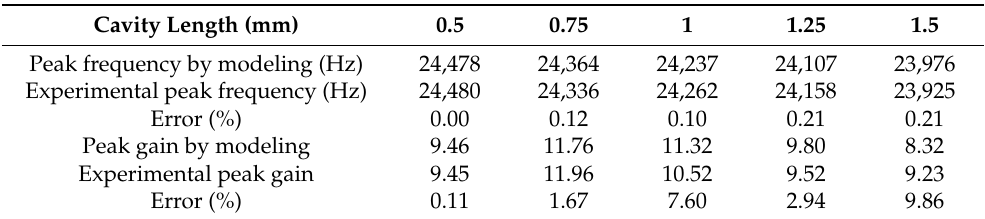
Table 6. Peak frequency and peak gain comparison of experimental data and calculated results based on the proposed modified Helmholtz resonator